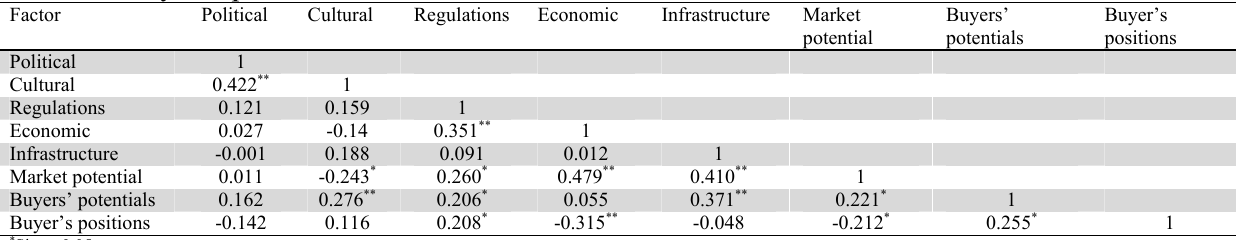
The summary of Spearman correlation test